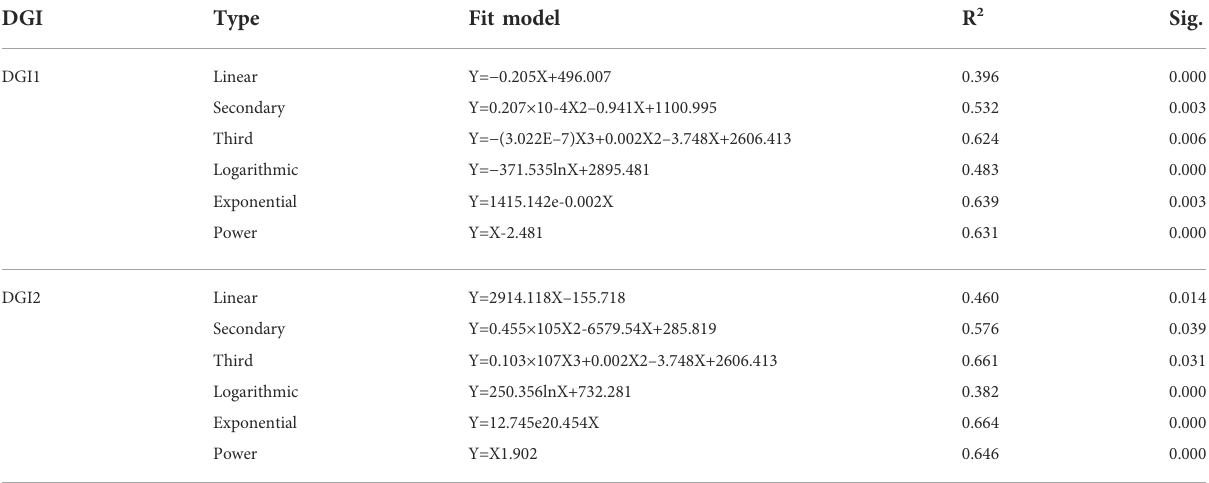
TABLE 4 Model for estimating the amount of combustible matter during the dead-grass season.